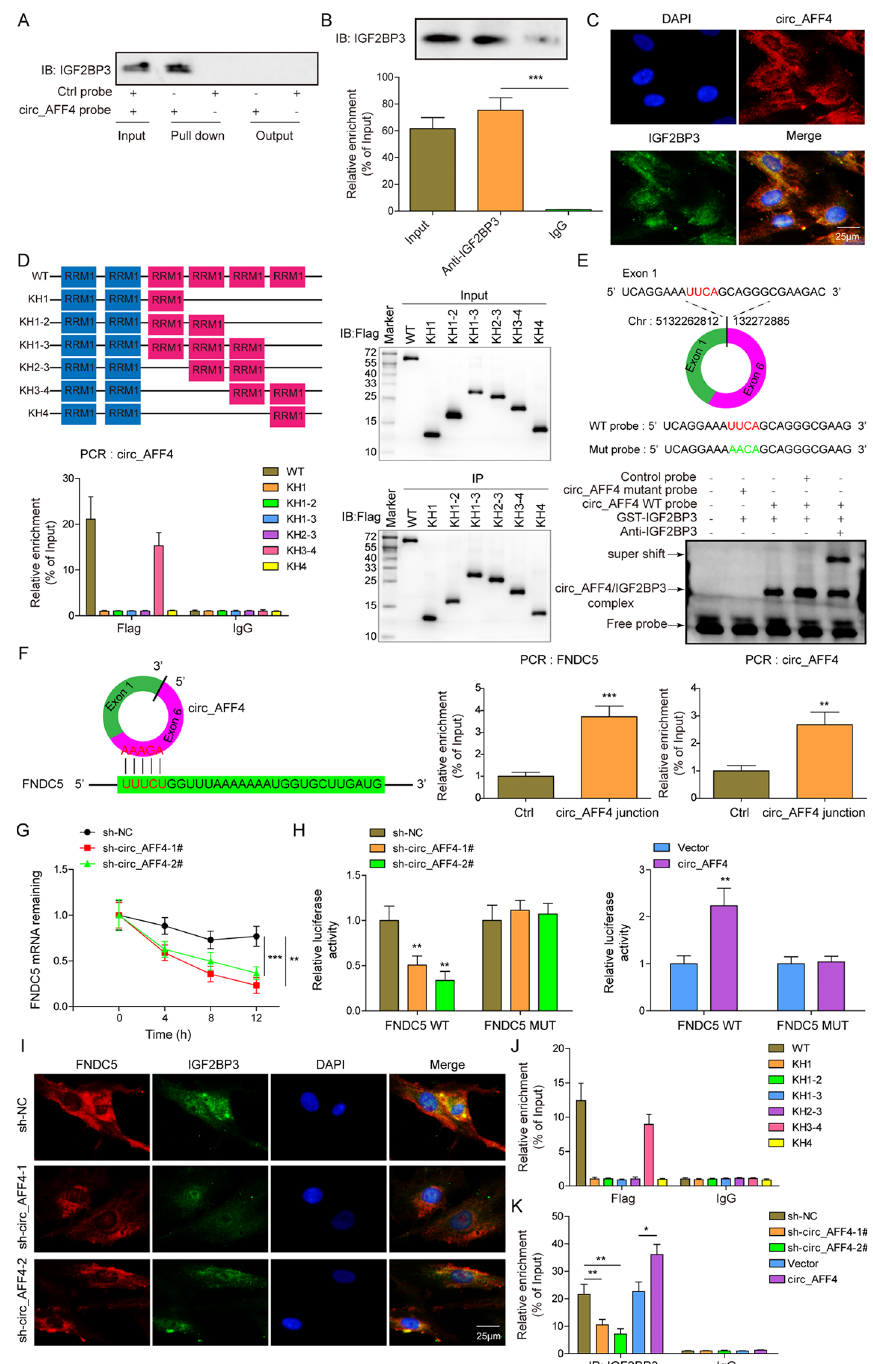
Fig. 3 Circ_AFF4 interacts with IGF2BP3 and stabilizes FNDC5 mRNA ( A ) Immunoblot analysis of IGF2BP3 after pulldown assay showing it interacts with circ_AFF4-IGF2BP3. ( B ) RIP assay indicating the interaction of IGF2BP3 with circ_AFF4 in BM-MSCs. ( C ) FISH assay showing the localization of circ_AFF4 and IGF2BP3 protein in the cytoplasm in BM-MSCs. Scar bar = 25 μm. ( D ) Upper left, RNA-binding domains within IGF2BP3 protein and a summary of IGF2BP3 truncations were shown in schematic structures. Bottom Left, rela- tive enrichment of circ_AFF4 indicating the association of circ_AFF4 with truncated IGF2BP3 compared to the control (IgG). Right, immunoblot analysis with anti-FLAG of BM-MSCs transfected with plasmids encoding FLAG-tagged WT or truncated IGF2BP3. ( E ) Top, UUCA motif located at exon 1-exon 6 junction site of circ_AFF4 and the RNA probe for RNA-EMSA assay were shown with a schematic illustration. Bottom, RNA-EMSA assay showed the bind- ing ability of purified IGF2BP3 with biotin-labeled oligonucleotides containing UUCA motif from circ_AFF4. ( F ) Left, sequence BLAST analysis indicating that circ_AFF4 directly targets the 3 ′ UTR of FNDC5. Right, relative enrichment of FNDC5 and circ_AFF4 showing the association of FNDC5 and circ_AFF4 junction compared to control. ( G ) Circ_AFF4 knockdown significantly reduced FNDC5 enrichment in BM-MSCs. ( H ) Luciferase activity of luciferase re- porter gene with FNDC5-WT or FNDC5-mut in circ_AFF4-overexpressed or circ_AFF4-knockdown BM-MSCs. ( I ) The co-localization of IGF2BP3 and FNDC5 was shown FISH image. Scar bar = 25 μm. ( J ) Relative enrichment of FNDC5 indicating the association of FNDC5 with truncated IGF2BP3 protein. ( K ) RIP assay showing the association of IGF2BP3 with FNDC5 upon circ_AFF4 knockdown or overexpression. * p < 0.05, ** p < 0.001 and *** p < 0.001. Each experi- ment was performed at least three times